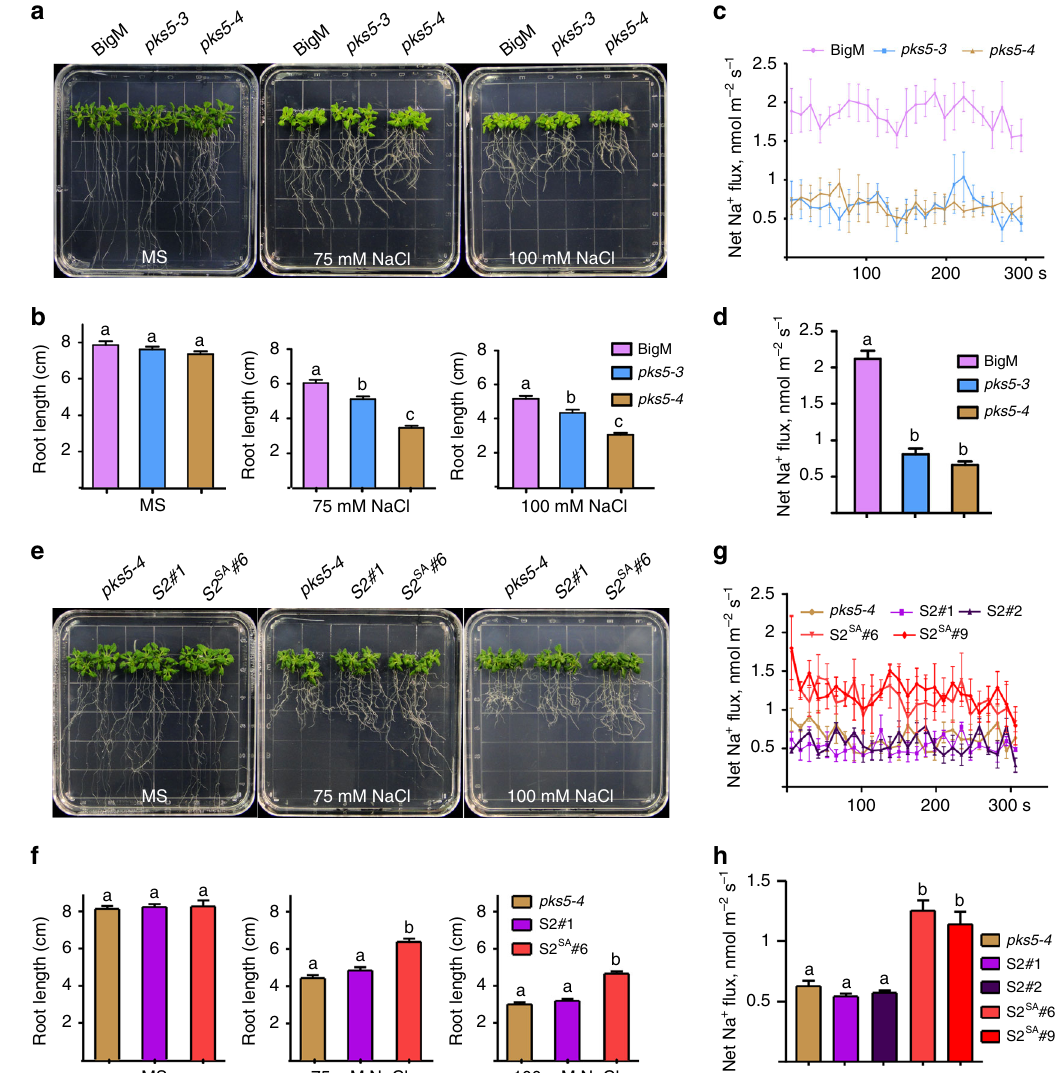
Fig. 3 SOS2 Ser294 mutation rescues the salt-sensitive phenotype of pks5-4 . a Salt sensitive analysis of BigM, pks5-3 , and pks5-4 . Five-day-old seedlings were transferred from MS to medium containing 75 or 100 mM NaCl. Photographs were taken 10 days after transfer. b Root length analysis of seedlings in ( a ). Error bars represent SD; p ≤ 0.05, Student ’ s t -test; n = 12. c Net Na + fl ux analysis at the meristem zone of BigM, pks5-3 , and pks5-4 by NMT. Five-day-old seedlings were pretreated with 100 mM NaCl for 24 h. Error bars represent SD; p ≤ 0.05, Student ’ s t -test; n = 6. d Calculated net Na + fl uxes from ( c ). e Salt sensitive analysis of pks5-4 and transgenic plants expressing Myc-SOS2 or Myc-SOS2 S294A in the pks5-4 background. S2, Pro35S:6×Myc-SOS2 in pks5-4 ; S2 SA , Pro35S:6×Myc-SOS2S294A in pks5-4 . Photographs were taken 10 days after transfer. f Root length analysis of seedlings in ( e ). Error bars represent SD; p ≤ 0.05, Student ’ s t -test; n = 12. g Net Na + fl ux analysis at the meristem zone of pks5-4 and different transgenic plants by NMT. Error bars represent SD; p ≤ 0.05, Student ’ s t -test; n = 6. h Calculated net Na + fl uxes from ( g ). For b , d , f , and h , signi fi cant differences are indicated by different lowercase letters. Source data of b – d and f – h are provided in the Source Data fi